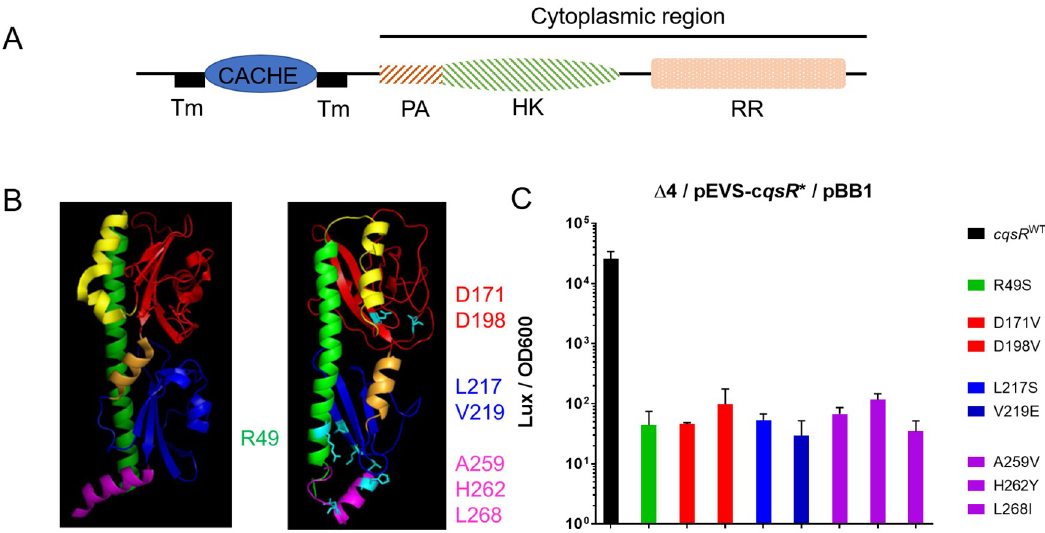
Fig 3. The CqsR CACHE domain is important for signal sensing and signal transduction. (A) CqsR is predicted to contain all the conserved cytoplasmic domains (phosphoacceptor (PA), histidine kinase (HK), and response regulator (RR) domains) of a hybrid histidine kinase with an N-terminal periplasmic CACHE domain flanked by two transmembrane helices (TM). (B) The predicted structure of the periplasmic CACHE domain of CqsR (right) is similar to that of Mlp37 (left). The residues identified as important for signal sensing and signal transduction are highlighted in cyan in the predicted structure. See main text for further details. (C) Eight periplasmic CqsR residues are involved in signal sensing and signal transduction. Relative light production (lux/OD 600 ) was measured in quadruple QS receptor ( Δ 4) strains carrying a plasmid producing CqsR with single amino changes as well as a HapR- dependent bioluminescence reporter. Alteration in the CqsR helix domain (R49S), CACHE pocket 1 region (D171V, D198V), CACHE pocket 2 region (L217S, V219E), or the transmembrane proximal regions (A259V, H262Y, L268I) impaired bioluminescence production at high cell-density (OD 600 > 1.5). Average values and standard errors from at least three independent replicates are